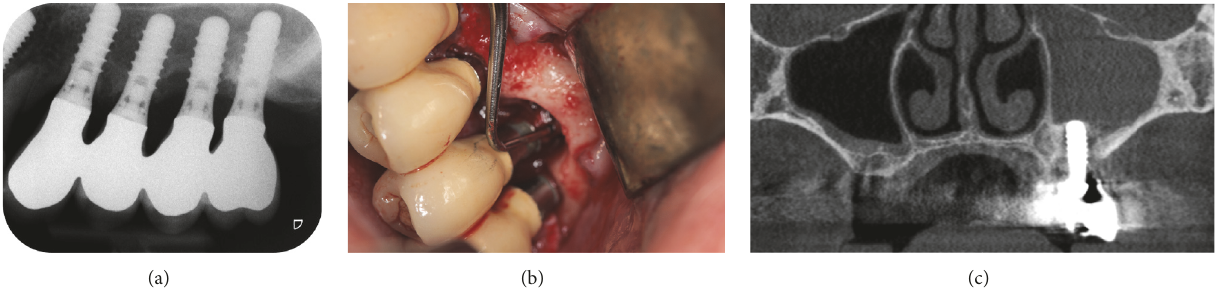
Figure 2: Ten years after implant placement. (a) Periapical radiograph, (b) clinical view, flap at site 25, and (c) cone-beam computed tomography image. Note the opacity of the left